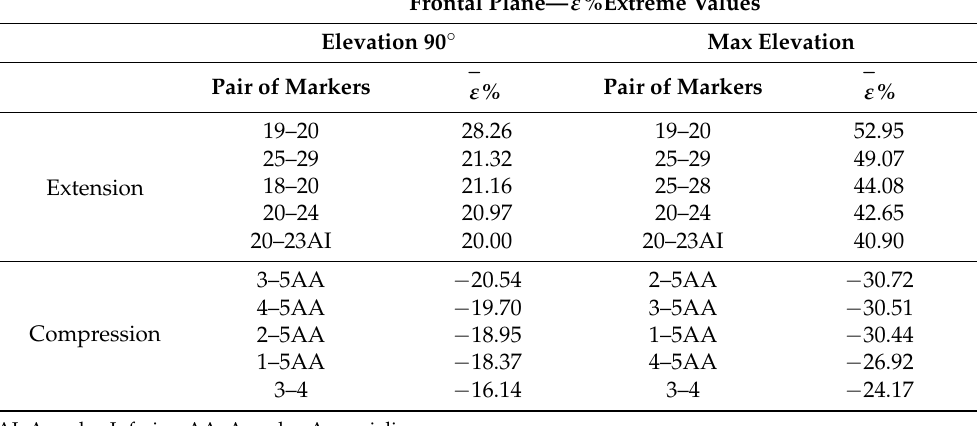
Table 3. Extreme percentage values of the mean strain ε % in both extension and compression during tasks performed in the frontal plane.